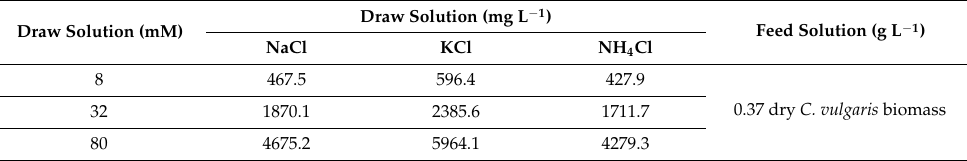
Table 1. Experimental conditions to test the effect of DS salts on algae.